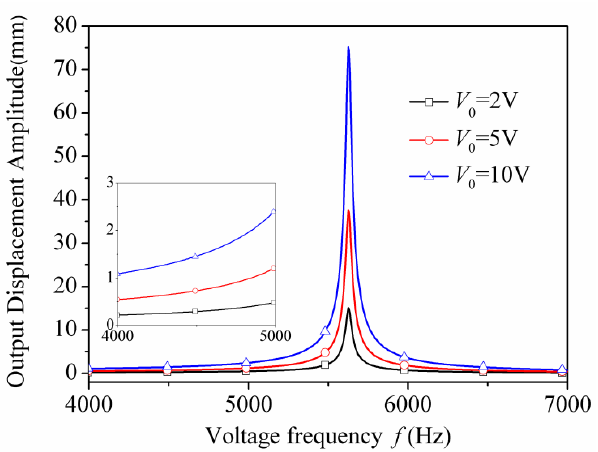
Figure 4. Relationship between the voltage frequency and the output displacement amplitude for different voltage amplitudes.